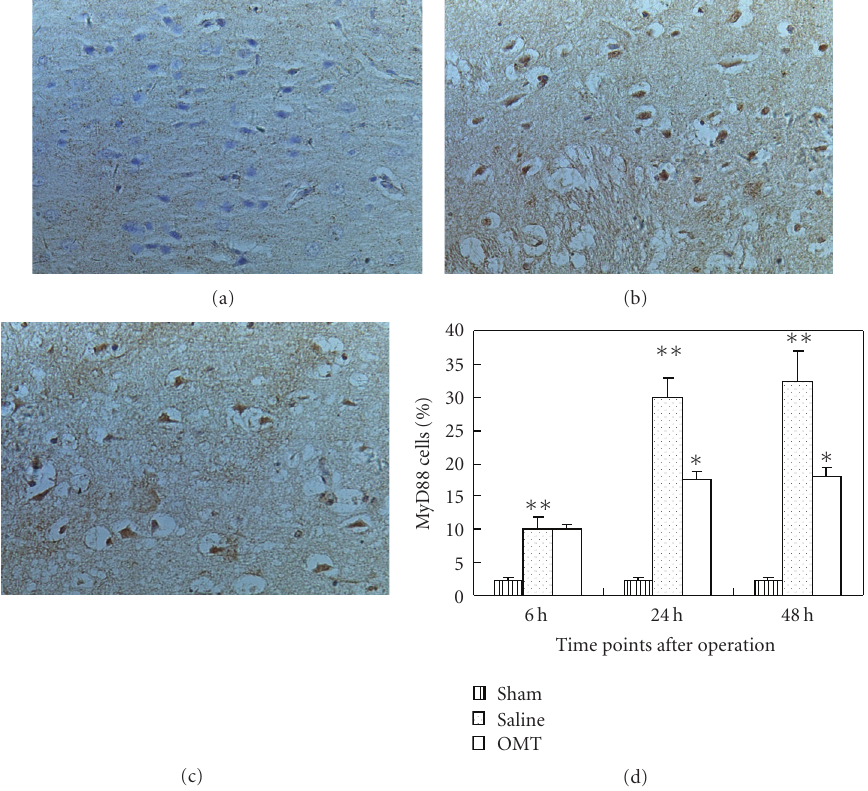
Figure 8: MyD88 expression detected by immunohistochemistry. (a) MyD88 expression in the sham group: MyD88 expression could be observed periodically in the sham group at 24 hours. (b) MyD88 expression in the saline group: MyD88 expression evidently increased in the saline group at 24 hours. Positive cells were defined as presenting bu ff y grains in cytoplasm. (c) MyD88 expression in the OMT treatment group: MyD88 expression decreased relatively in the OMT treatment group at 24 hours. (d) MyD88 expression in each group at all time points: Expression of MyD88 protein was evidently higher in the saline group at 6 hours and lasted up to 48 hours. There was no di ff erence between saline and OMT group at 6 hours. Compared with the saline group at 24 hours and 48 hours, expression of MyD88 protein was lower in the OMT treatment group, and the di ff erence was significant ∗∗ P < . 05 compared with Sham and ∗ P < . 05 compared with saline